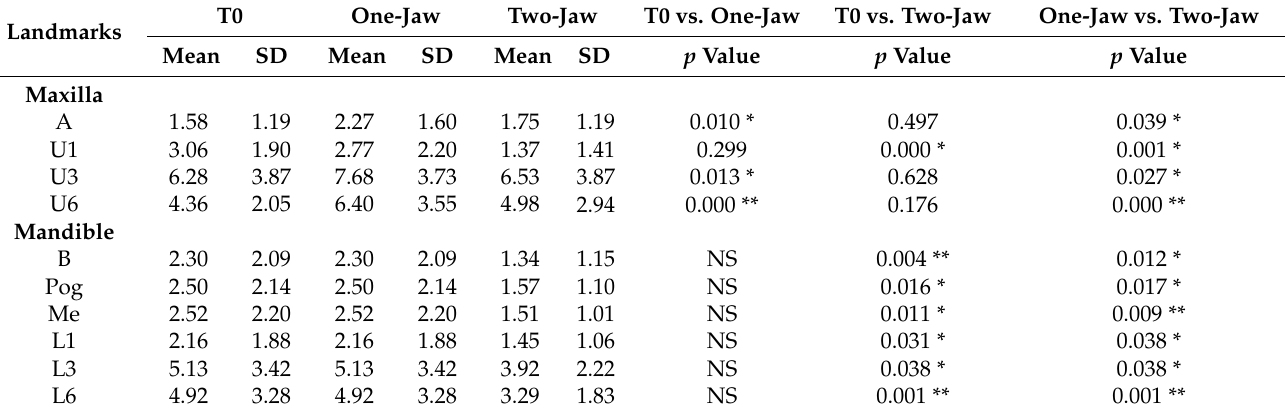
Table 5. Asymmetry index of T0 group, one-jaw design, and two-jaw